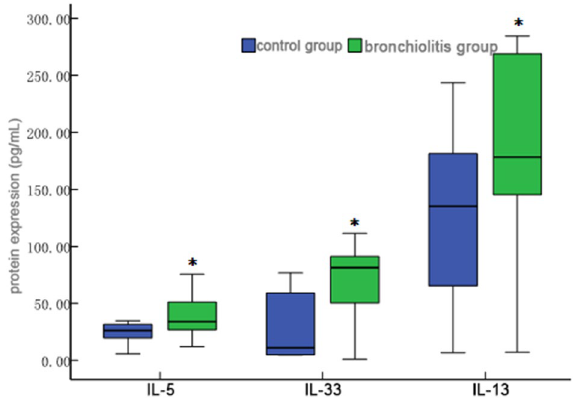
Figure 6. IL-5, IL-33 and IL-13 protein levels in control group and bronchiolitis group. IL-5, IL-33 and IL-13 in peripheral blood of the bronchiolitis group were higher than those in the control group (* P <